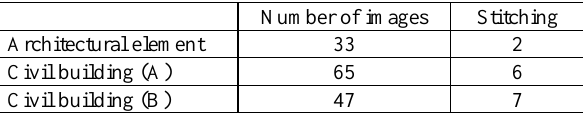
Figure 1. Datasets used for visual accuracy tests